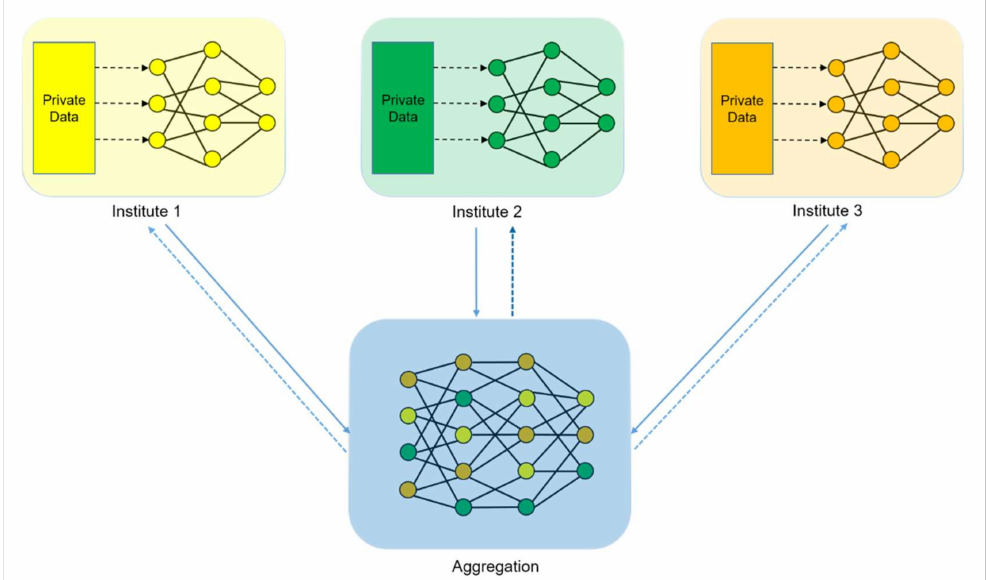
Figure 1. Distributed learning model for medical